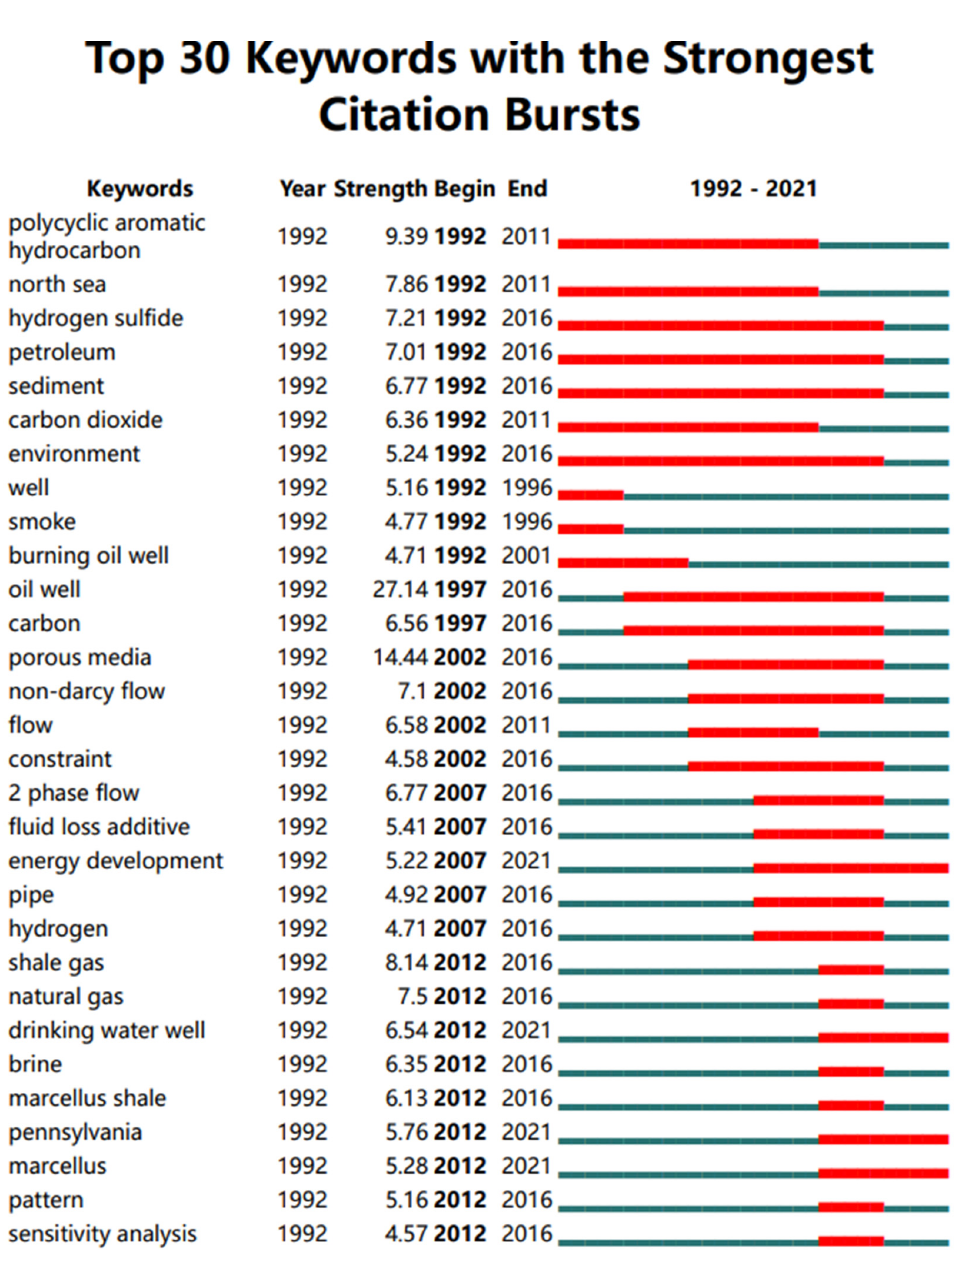
Figure 16. The emergence words in oil and gas wells research in 1992–2021.